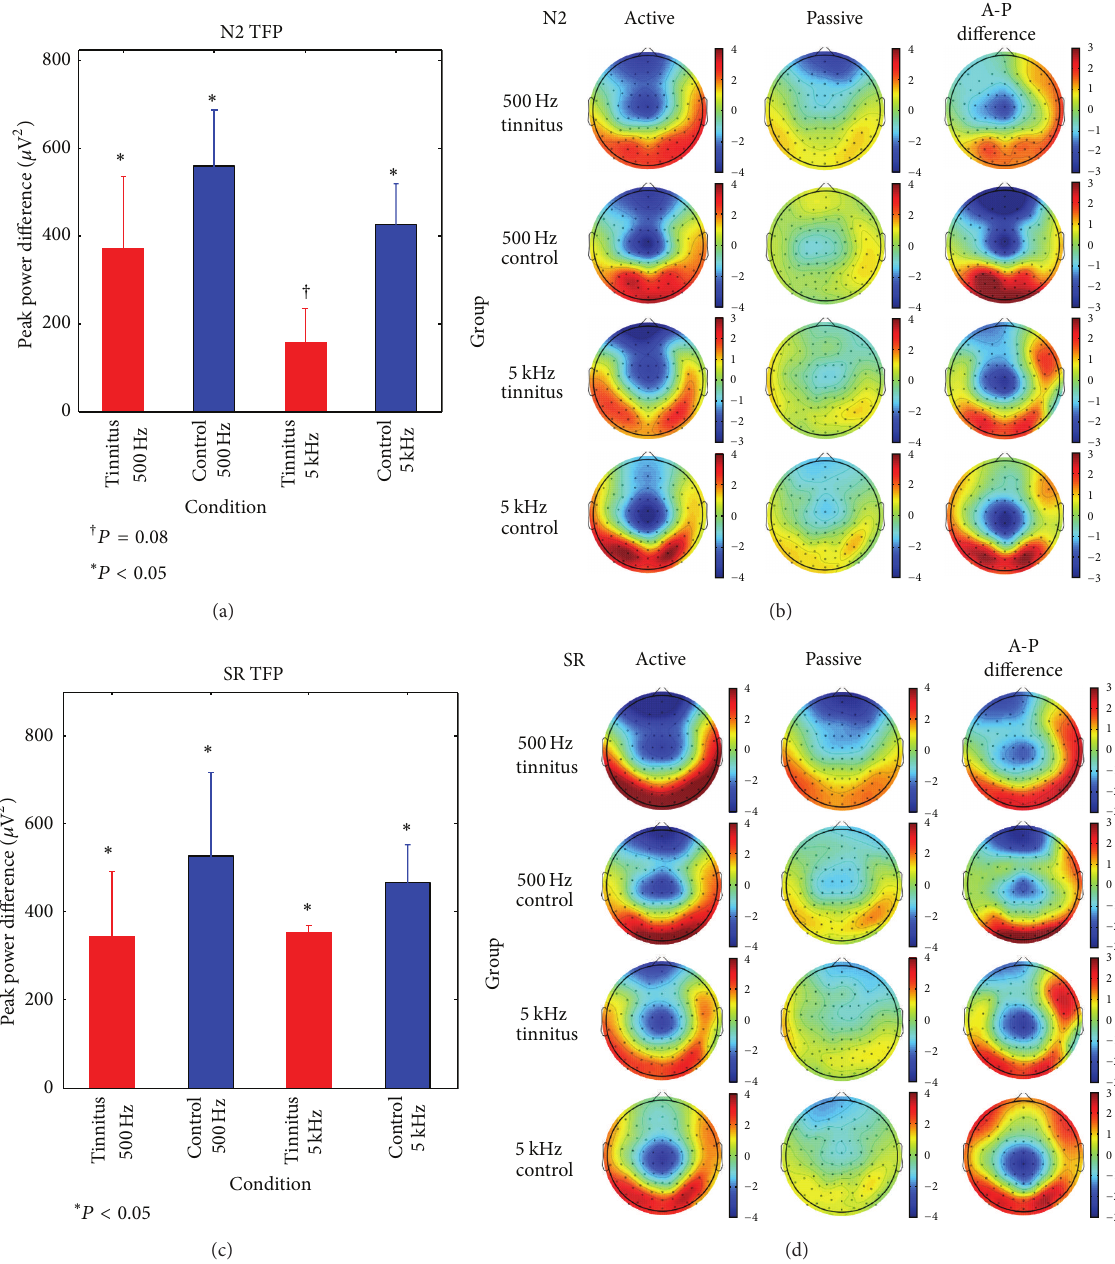
Figure 6: N2 and auditory SR scalp topography and attention effects. (a) Effect of attention on N2 TFP in each subject group (active-passive blocks). (b) Active, passive, and difference voltage maps for N2 at the peak latency of electrode Fz. (c) Effect of attention on SR TFP in each subject group (active-passive blocks). (d) Active, passive, and difference voltage maps for SR averaged from 400 to 900ms. The error bars in (a) and (c) are one standard error ( ∗ 𝑃 < 0.05 ; † 𝑃 = 0.08 ).